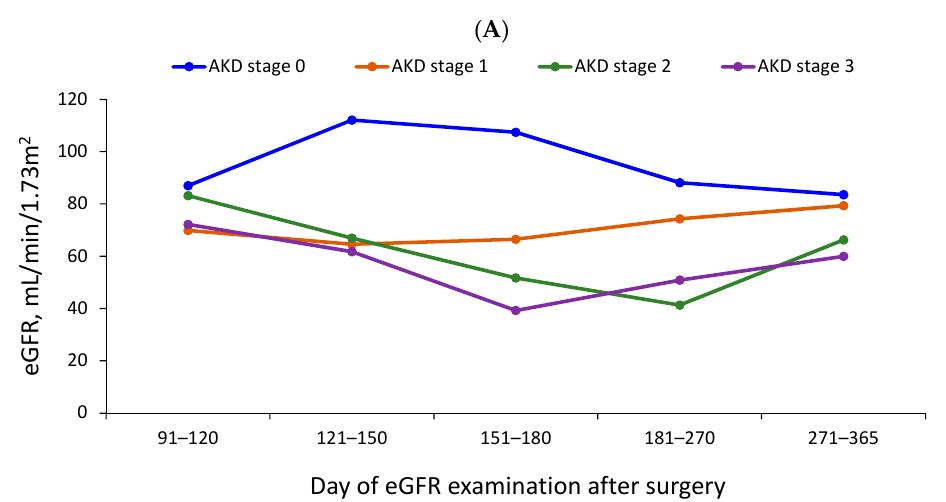
Table 1. Late outcomes during follow-up in the expectation maximization imputation cohort. Late Outcomes (>90 Days)